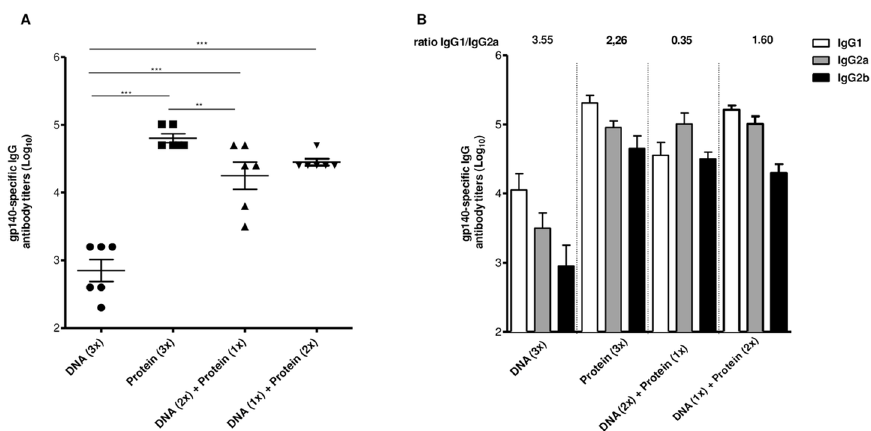
Fig 5. Heterologous prime-boost influences the quality of Env-specific humoral response. BALB/c mice (n = 6 per group) received 3 doses of the DNA vaccine (100 μ g) encoding gp140 (Yu2-gp140) i.m. or 3 doses of gp 140 (10 μ g) in the presence of poly (I:C) s.c. or 2 doses of DNA plus 1 dose of gp140 or 1 dose of DNA plus 2 doses of gp140. Fifteen days after last dose, serum was collected and analyzed by ELISA. (A) Total gp140-specific IgG antibody titers on a logarithmic scale; (B) Specific IgG subtypes. *** p <